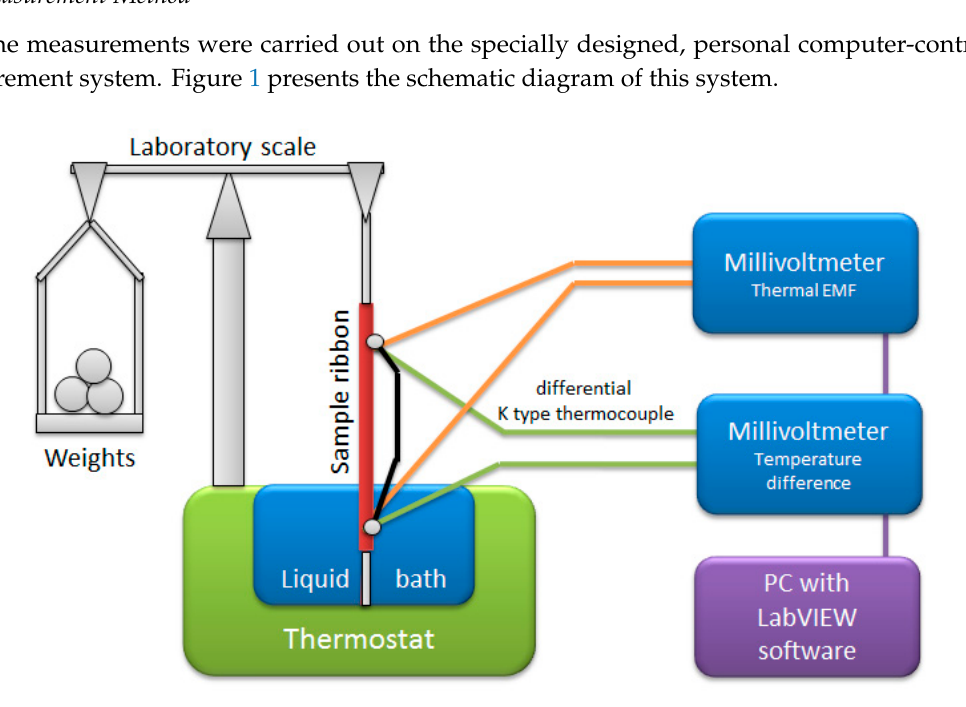
Figure 1. Schematic diagram of the developed Seebeck ( σ ) system.